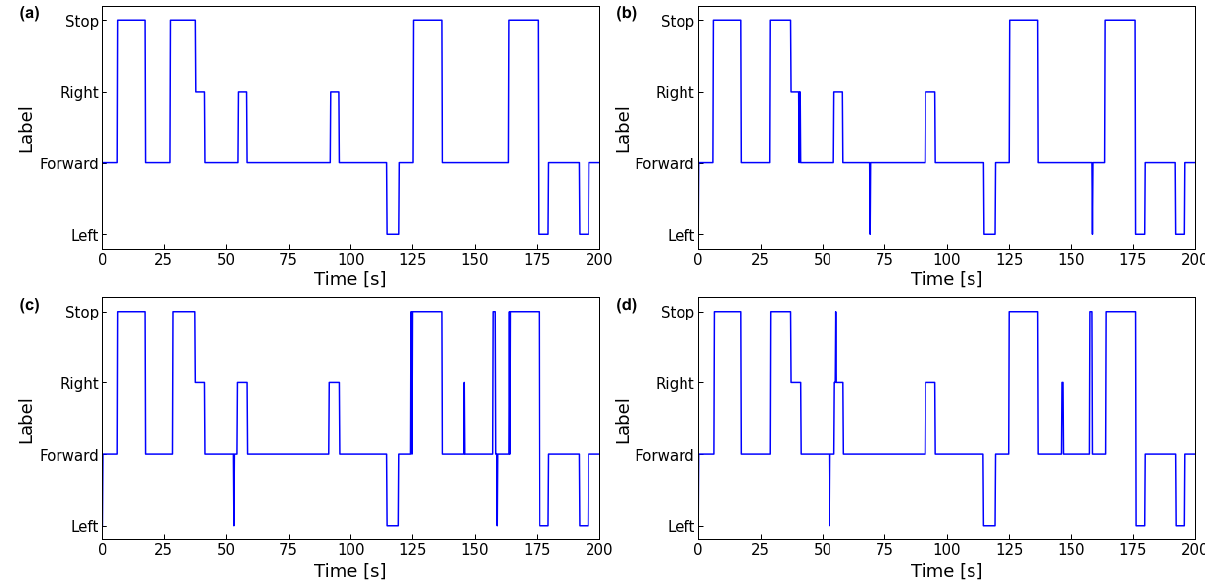
Figure 8. Comparison of output results of each model (0 s to 200 s): ( a ) Ground truth; ( b ) Output of 1DCNN-LSTM; ( c ) Output of 1DCNN; ( d ) Output of